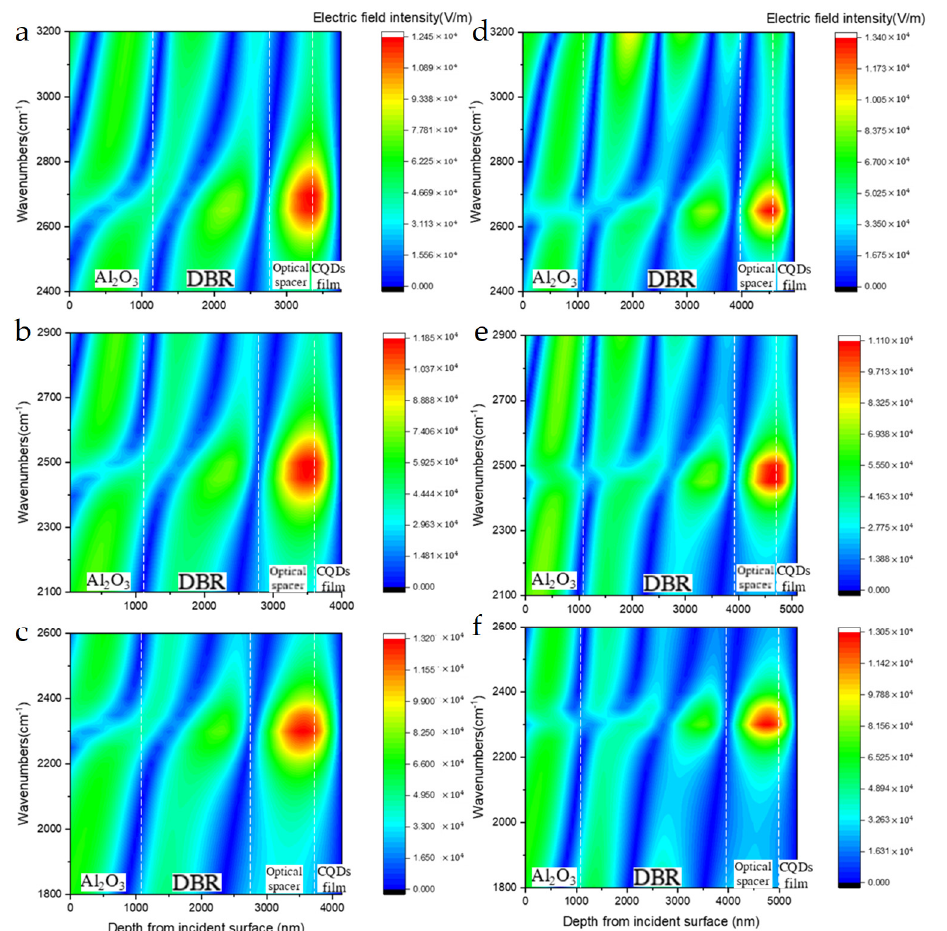
Figure 2. Optical field distributions of the resonant cavity. Optical field distributions for optical spacer layer thicknesses of ( a ) 0.6, ( b ) 0.8, and ( c ) 1.0 µm of one layer of DBR are shown. ( d – f ). The optical field distributions for two layers of DBR with the same optical spacer layer thickness as one layer. Different layer positions are marked by white dashed lines.